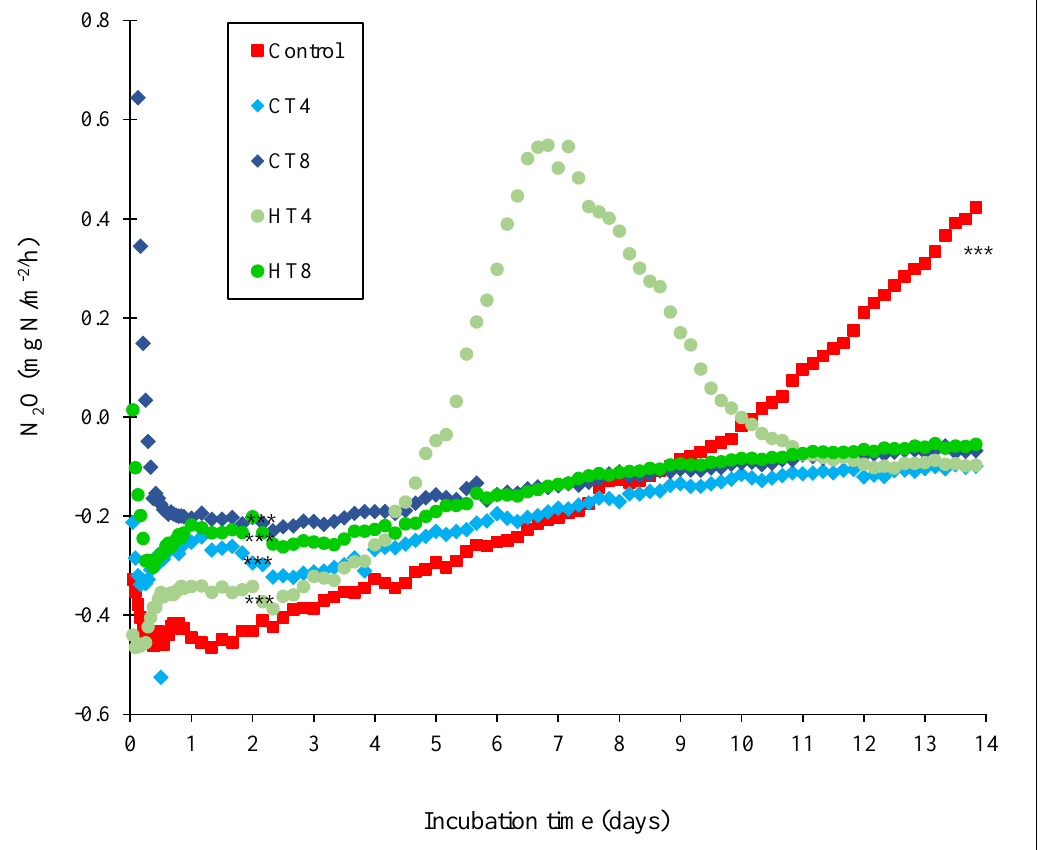
Figure 4. Hourly rates of nitrous oxide (N 2 O) emission during in vitro dairy cattle manure incubation (n = 3) experiment for 14 d composting period. CT = quebracho condensed tannins; HT = chestnut hydrolysable tannins. All treatments were a sink (negative emissions) except for the control. Asterisks (***) represent significance levels of p <